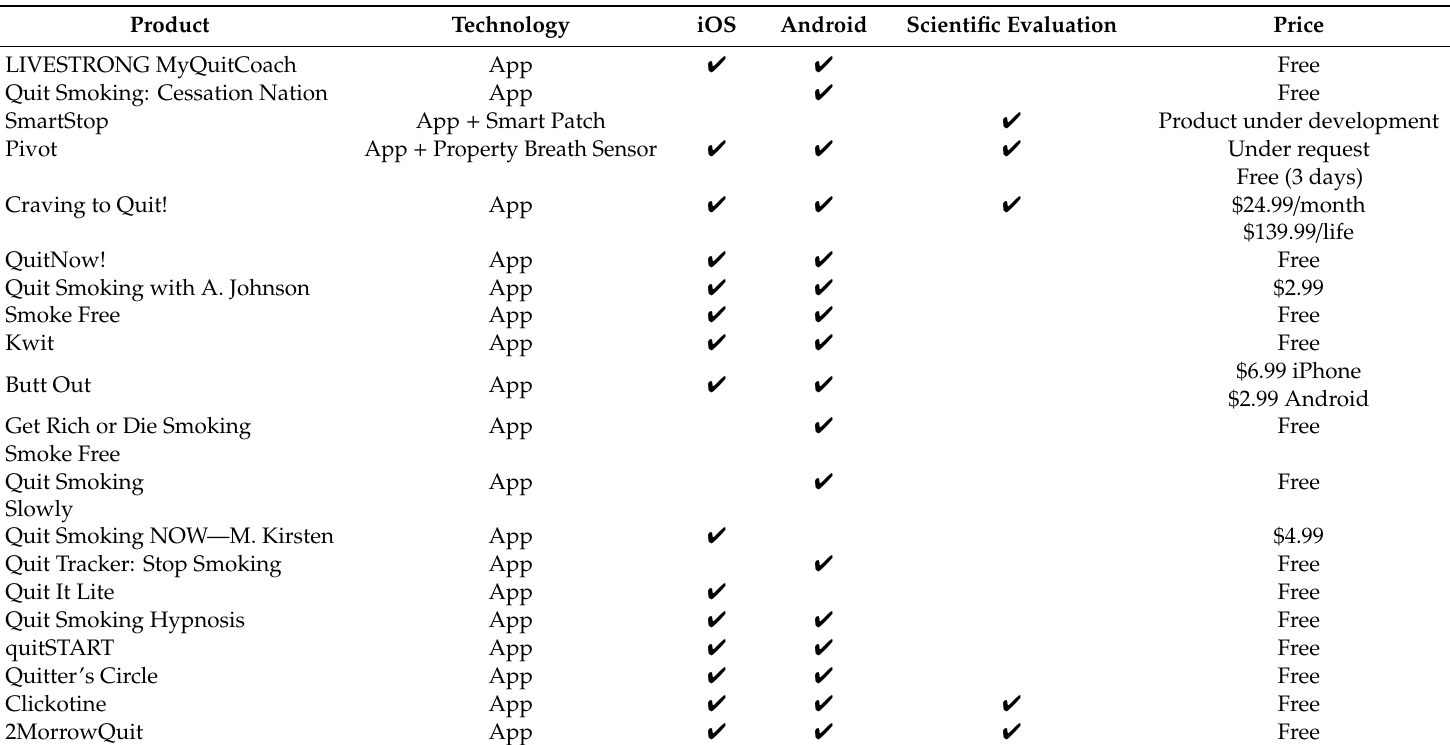
Table 2. Summary of the quit smoking applications described in this study. Product Technology iOS Android Scientific Evaluation Price